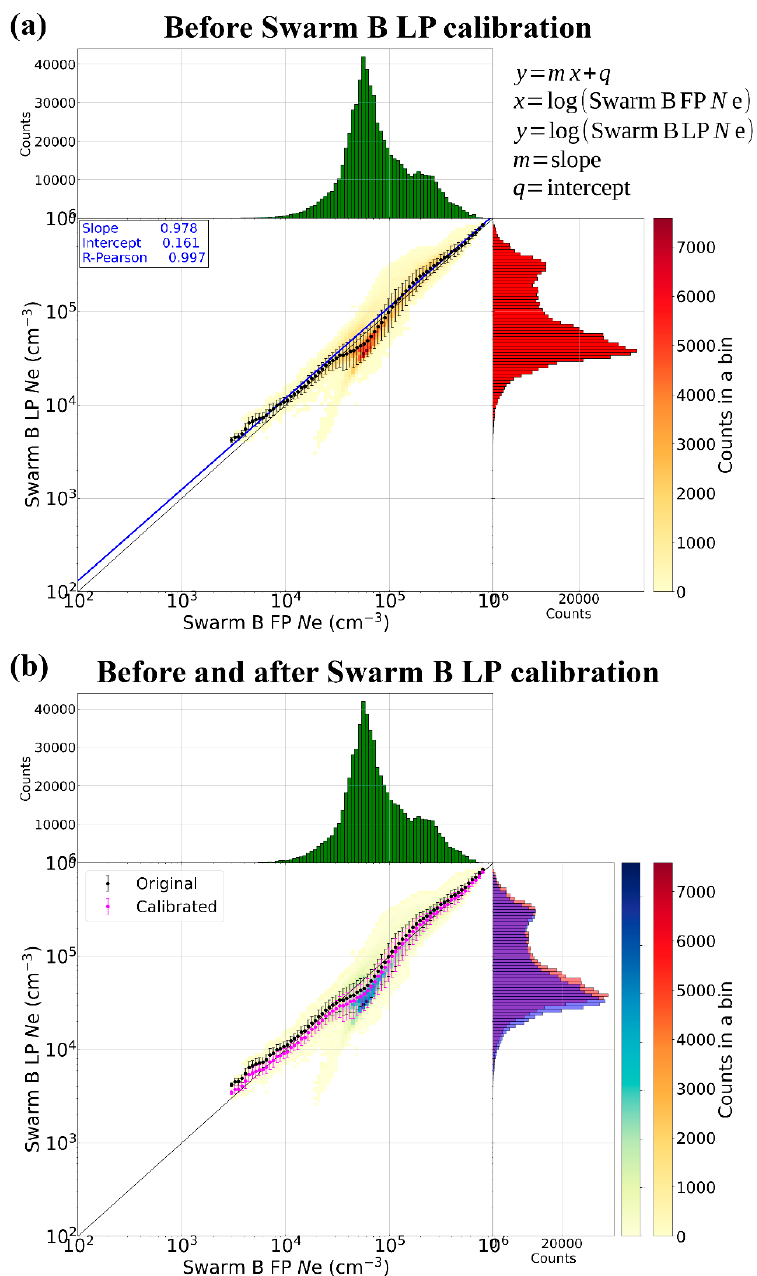
Figure 1. JPDs between Swarm B LP N e observations ( y -axis) and Swarm B FP N e observations ( x -axis), both recorded from 1 January 2019 to 30 September 2021 in the range of latitudes between 70 ◦ S and 70 ◦ N for the daytime sector (13:00 − 15:00 LT). Panel ( a ) refers to Swarm B LP observations before the calibration, while Panel ( b ) also shows the distribution of Swarm B LP observations after applying the calibration. In each panel, histograms of the counts are also reported: on the right and in red for Swarm B LP before the calibration, in blue for Swarm B LP after the calibration, and on the top and in green for Swarm B FP. The black dots refer to the mean values of original Swarm B LP N e observations conditioned by Swarm B FP N e observations, with the corresponding standard deviation as error bar. The magenta dots refer to the mean values of calibrated Swarm B LP N e observations conditioned by Swarm B FP N e observations, with the corresponding standard deviation as error bar. The blue line in Panel ( a ) is the linear fit on black dots, with coefficients given in the legend. The thin black line is the first-third quadrant bisector.